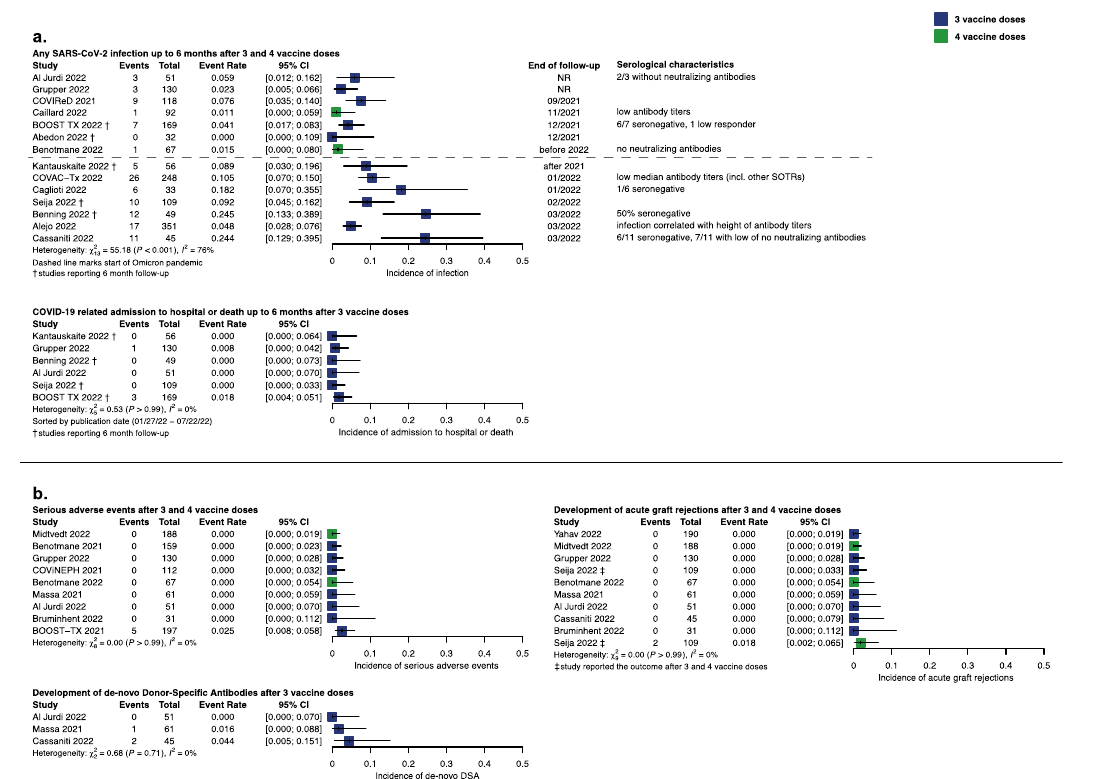
Figure 3. Response and event rate for prioritized efficacy and safety outcomes depicted as forest